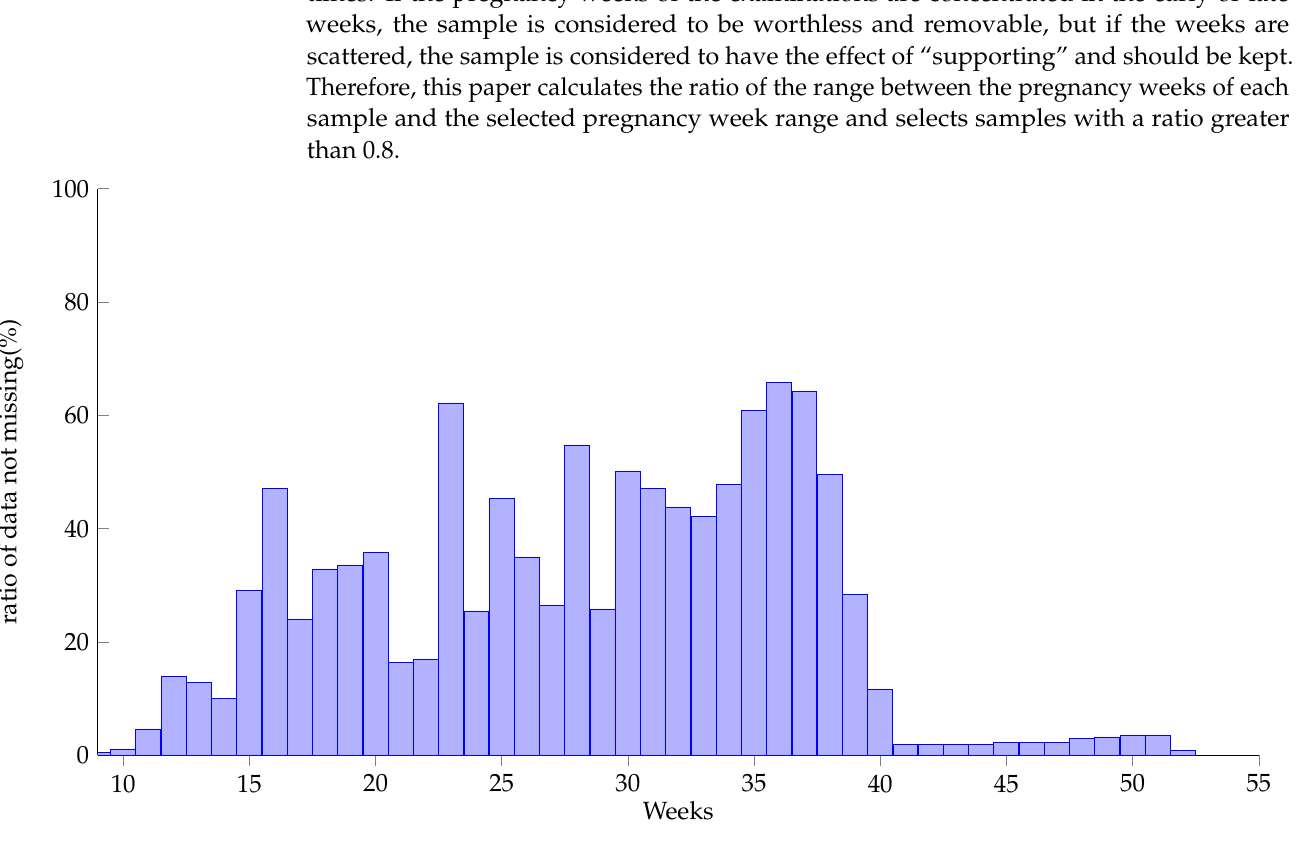
Figure 3. Ratio of data not missing by pregnancy weeks.